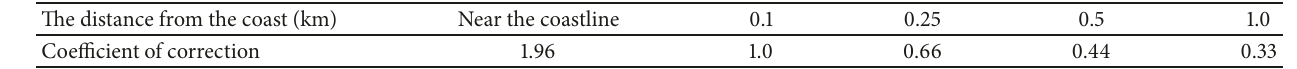
Table 3: Chloride concentration correction factor 𝑘 󸀠 on the surface.